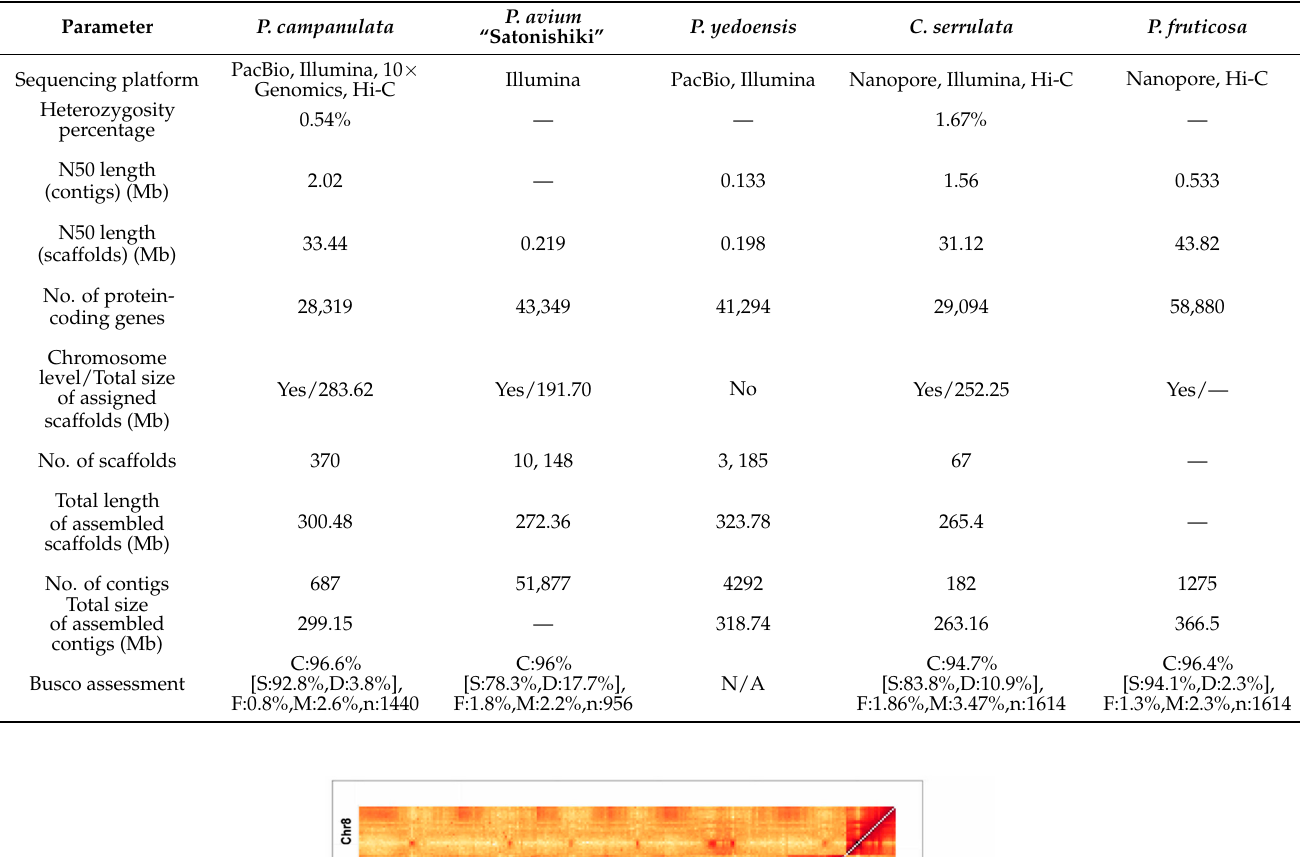
Table 1. Comparison of the genome assembly among the four cherry species.